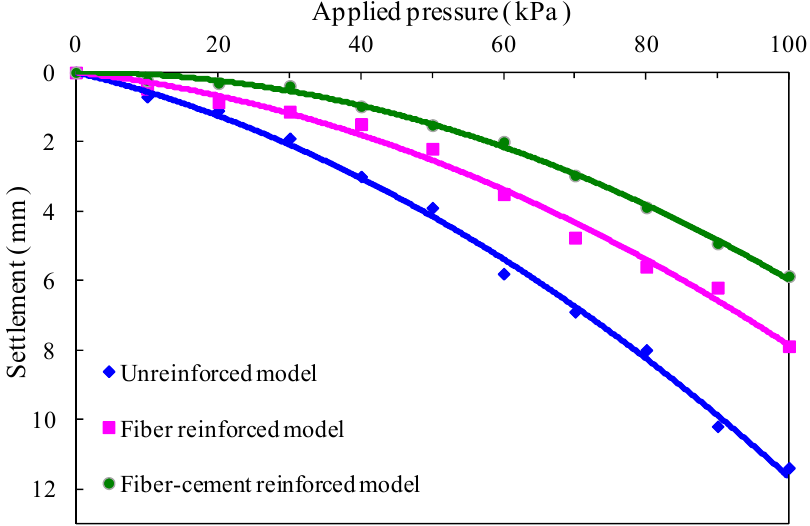
Figure 5. Applied pressure-settlement curves for unreinforced and reinforced subgrade models. ( a ) Unreinforced subgrade model; ( b ) fiber-reinforced subgrade model; ( c ) fiber-cement-reinforced subgrade model.